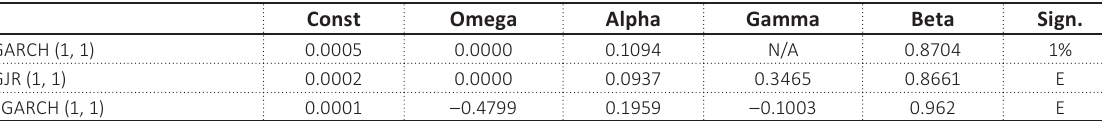
Table 3. Statistical property of GARCH (1, 1), GJR (1, 1), and EGARCH (1, 1)